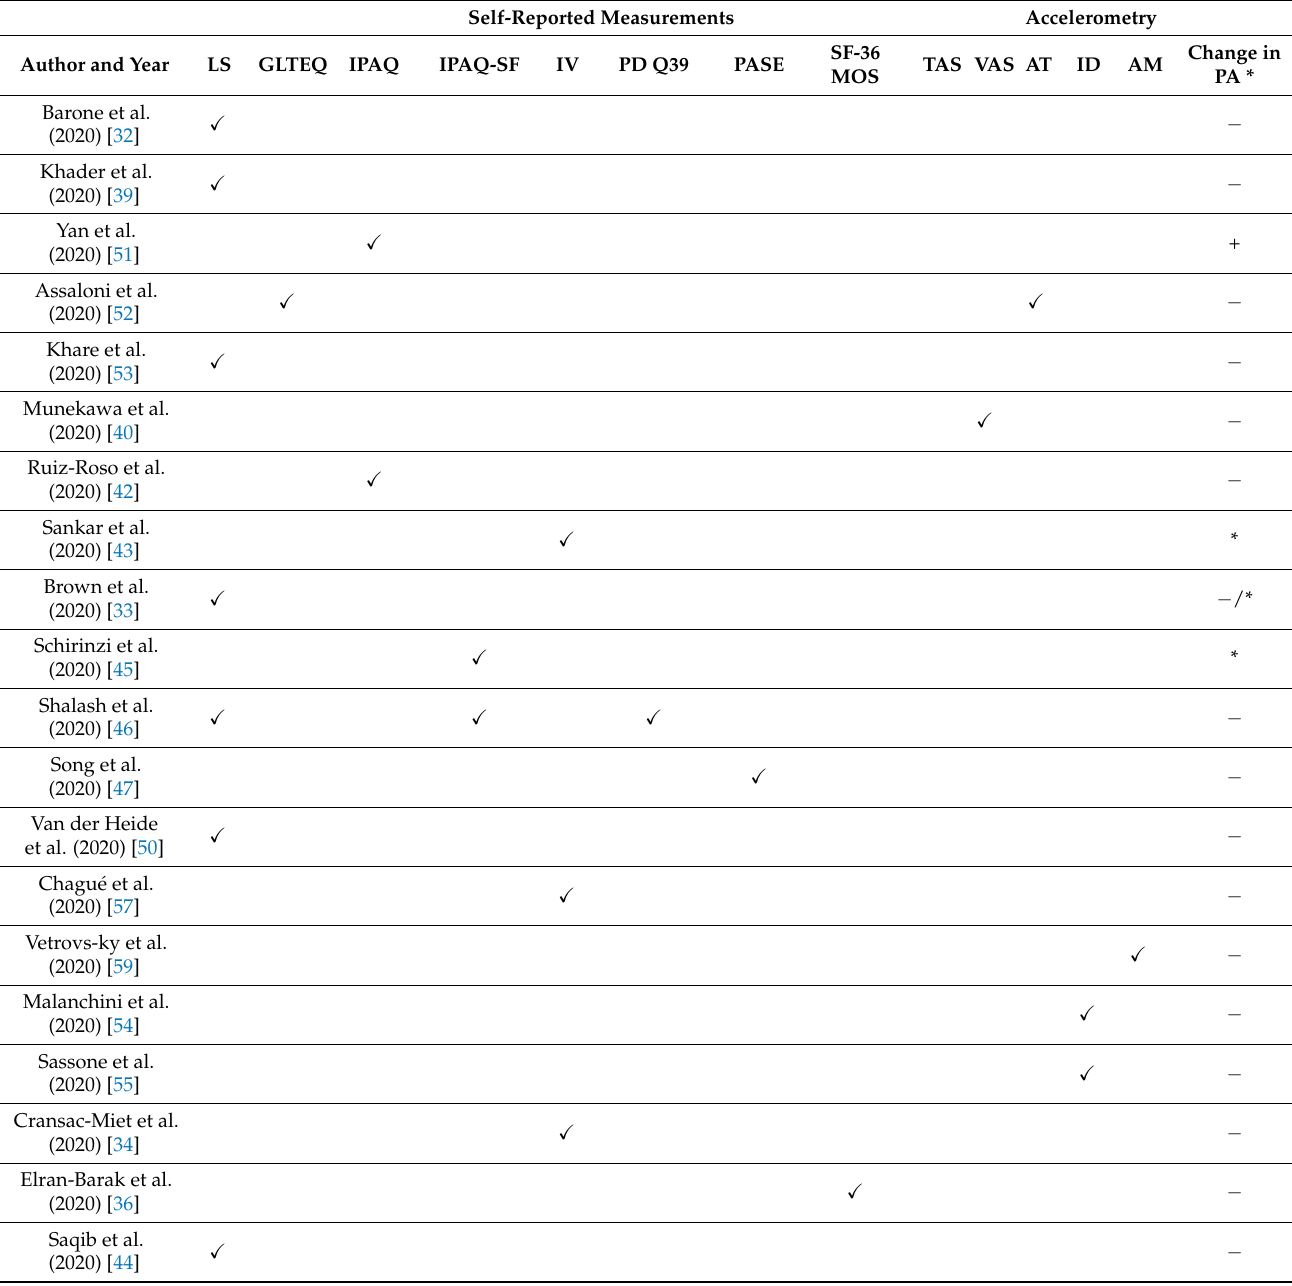
Table 4. Different physical activity measurements used in the included